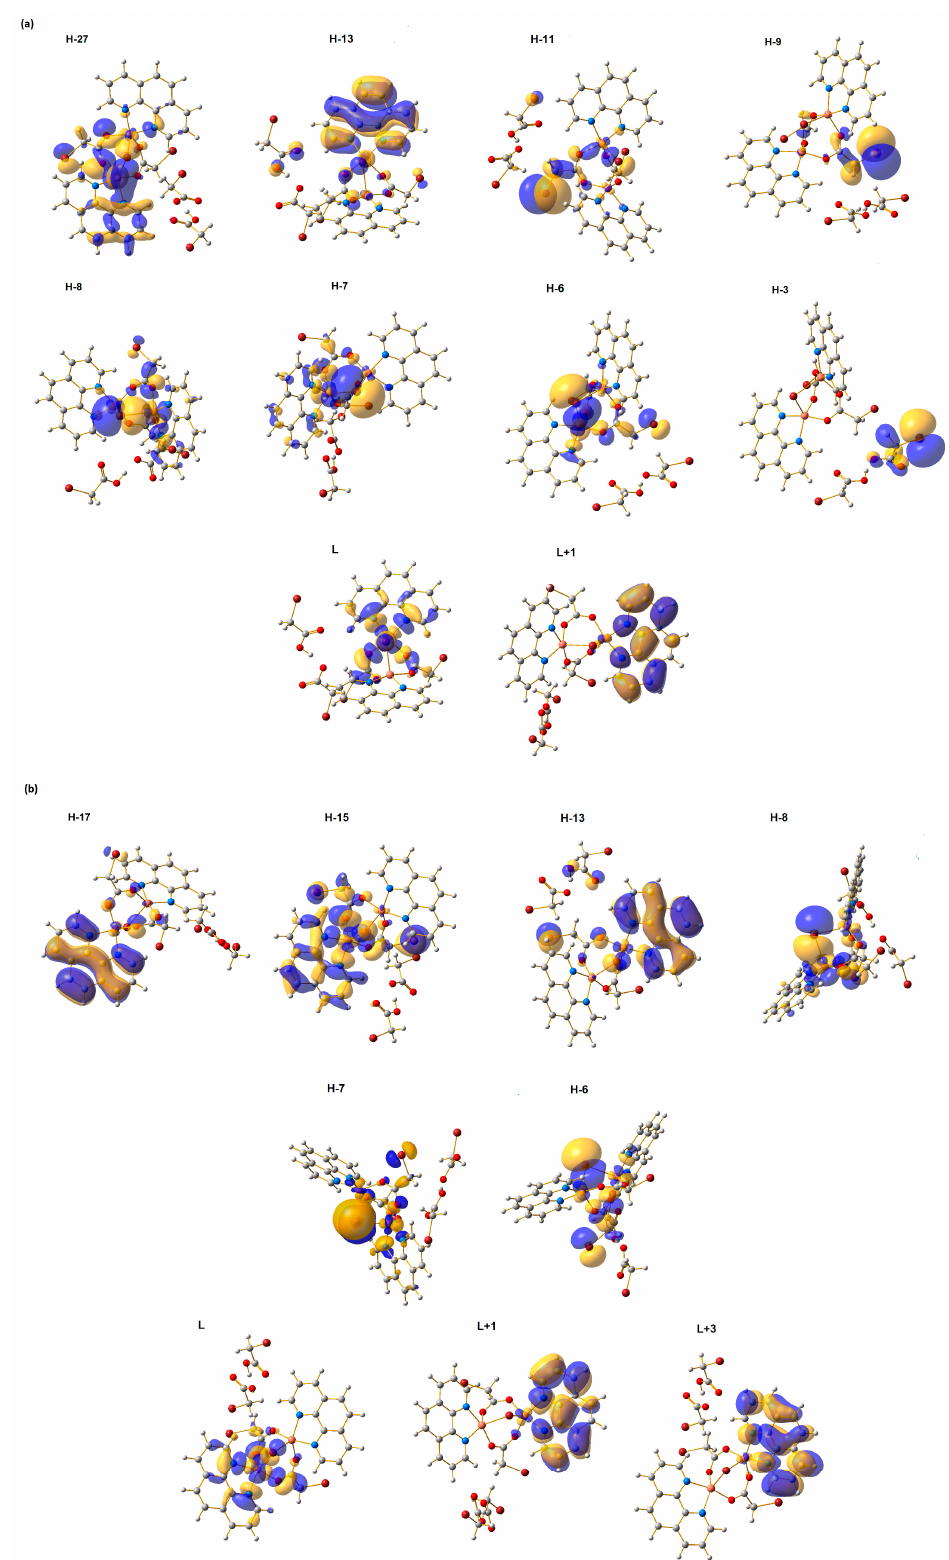
Figure 4. Calculated molecular orbitals of compound 1 : α ( a ) and ß ( b ). H letter indicates HOMO, L-LUMO, and ±(number) represents subsequent orbitals above HOMO and LUMO, respectively.